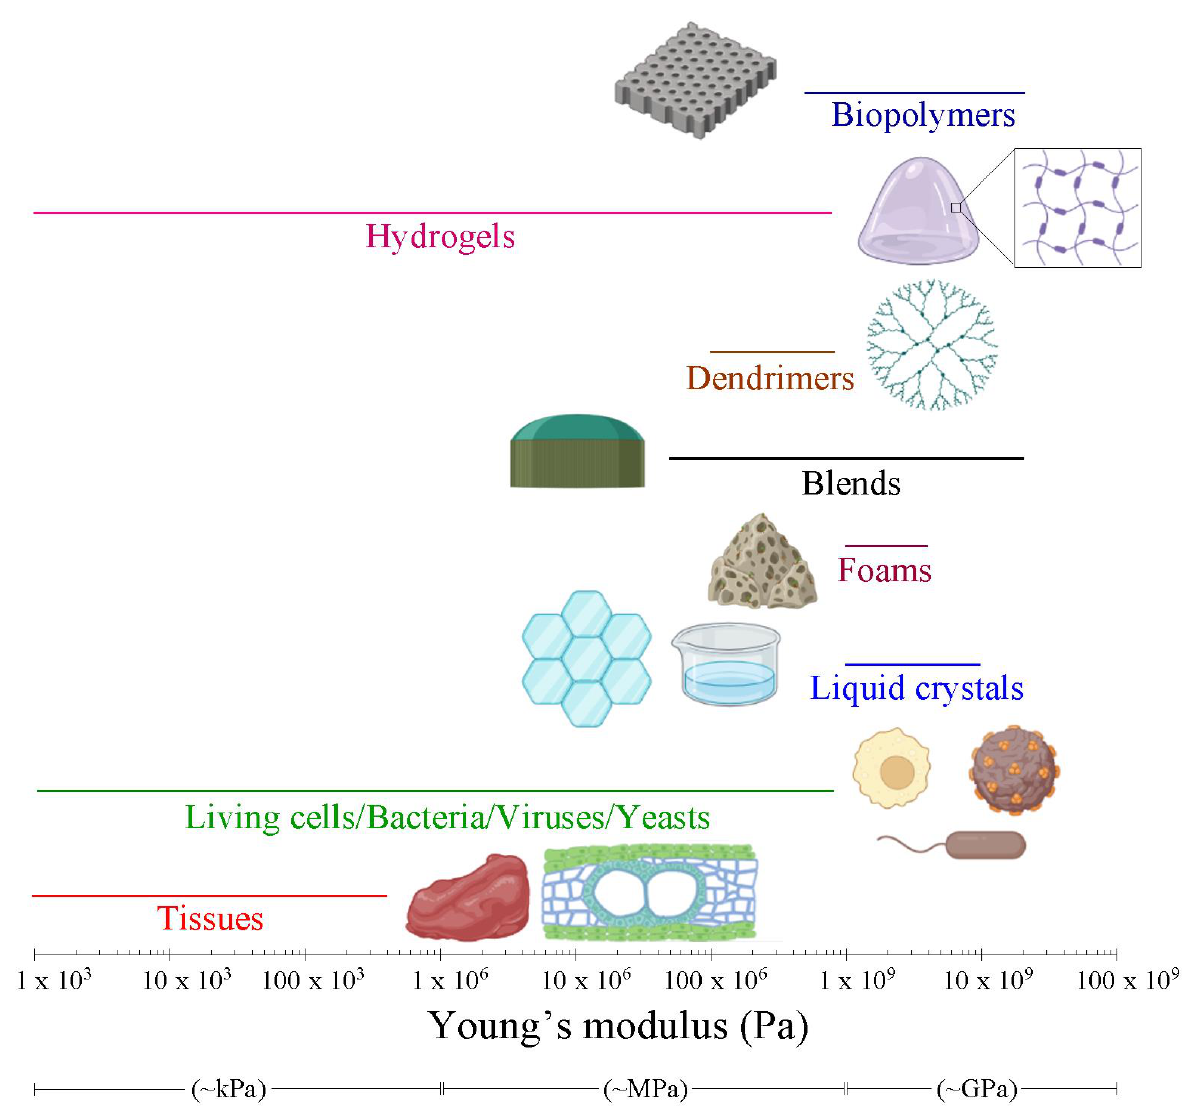
Figure 6. Elastic modulus ranges covered by the soft matter systems expressed in semilogarithmic scale. Images were created using BioRender.com.